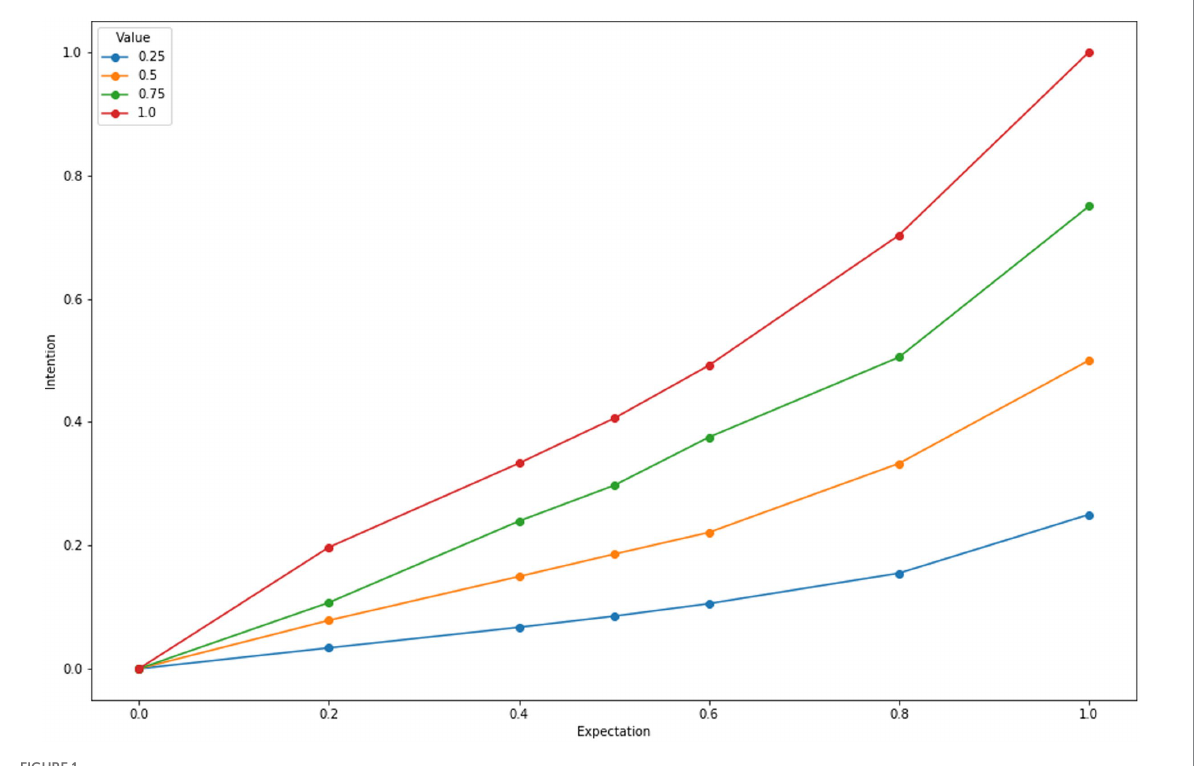
FIGURE 1 Expectancy value assessments for multiple simulation runs of ACT-R in which subjective values associated with success range from 0.25 to 1.0, and the probability of success ranges from p = 0 to